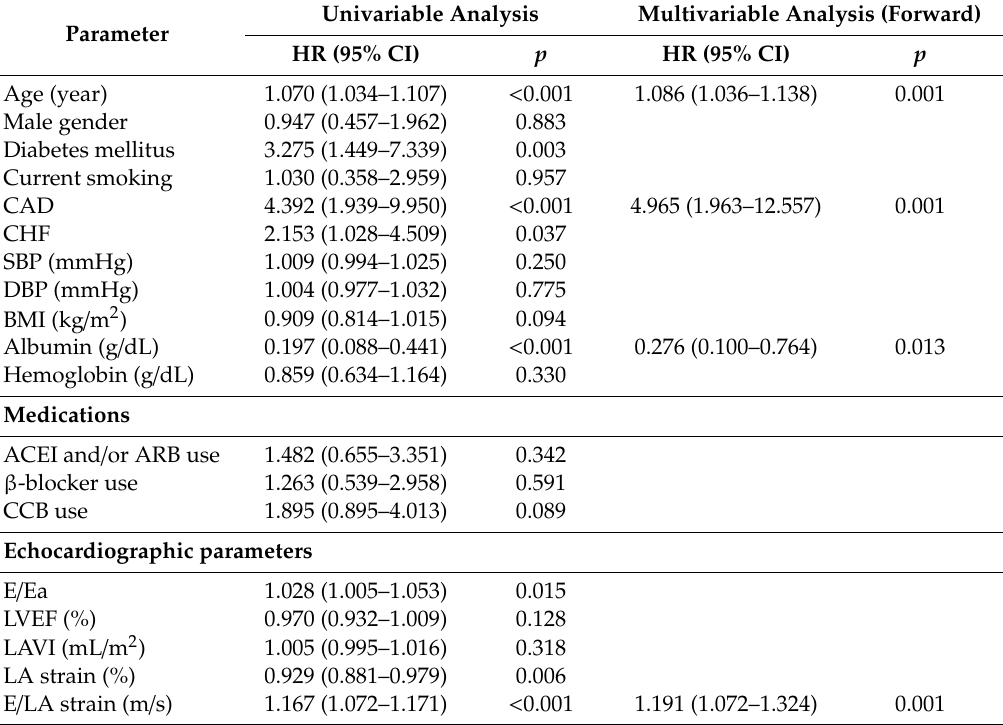
Table 4. Predictors of total mortality using the Cox proportional hazards model.